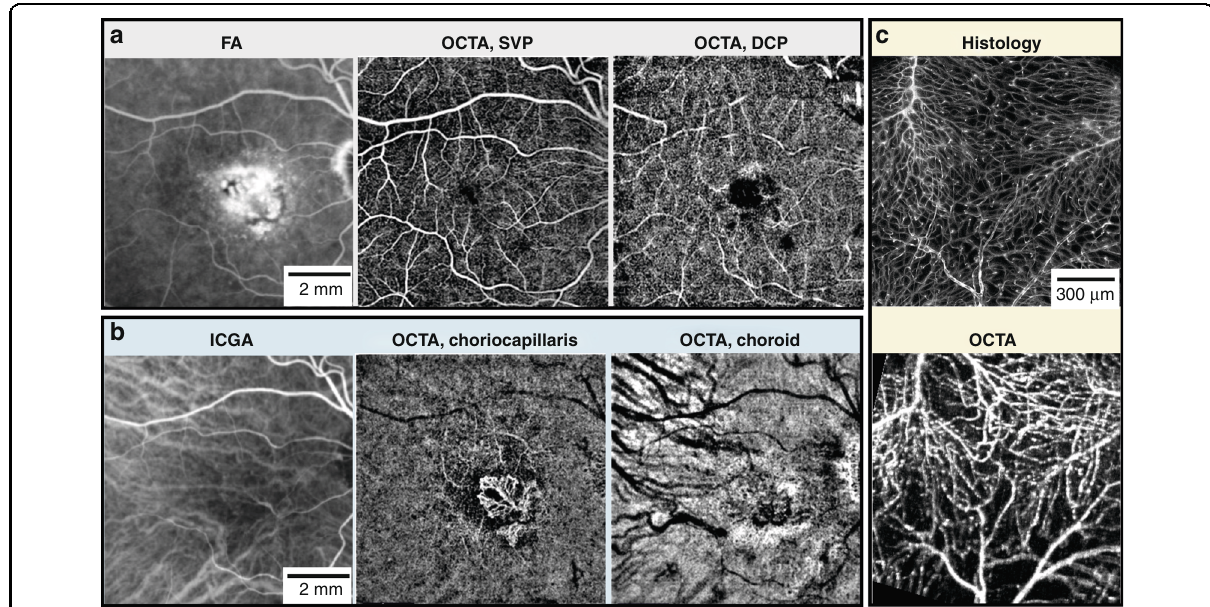
Fig. 4 Comparison of OCTA, fl uorescein angiography (FA), indocyanine green angiography (ICGA), and histology. a , b FA, ICGA, and OCTA segmented to super fi cial vascular plexus (SVP), deep capillary plexus (DCP), choriocapillaris, and choroid, from a patient with choroidal neovascularization secondary to age-related macular degeneration. a FA shows leakage of dye obscuring details of the fi ne blood vessels within the choroidal neovascularization that can be more clearly seen in OCTA at the level of choriocapillaris than ICGA in ( b ). c Confocal microscopy and OCTA from an isolated perfused porcine eye ex vivo. For the OCTA image acquisition, the whole porcine eyeball was used, and the retinal vasculature was perfused using red blood cells. After the OCTA experiment, retinal vasculature histology was performed. The retina was perfused with fl uorescein as a contrast agent, and the eyeball was cut open, fl at-mounted and imaged using confocal scanning laser microscopy. Both images are maximum intensity projections from the full retinal thickness. c Adapted with permission from Yu et al.